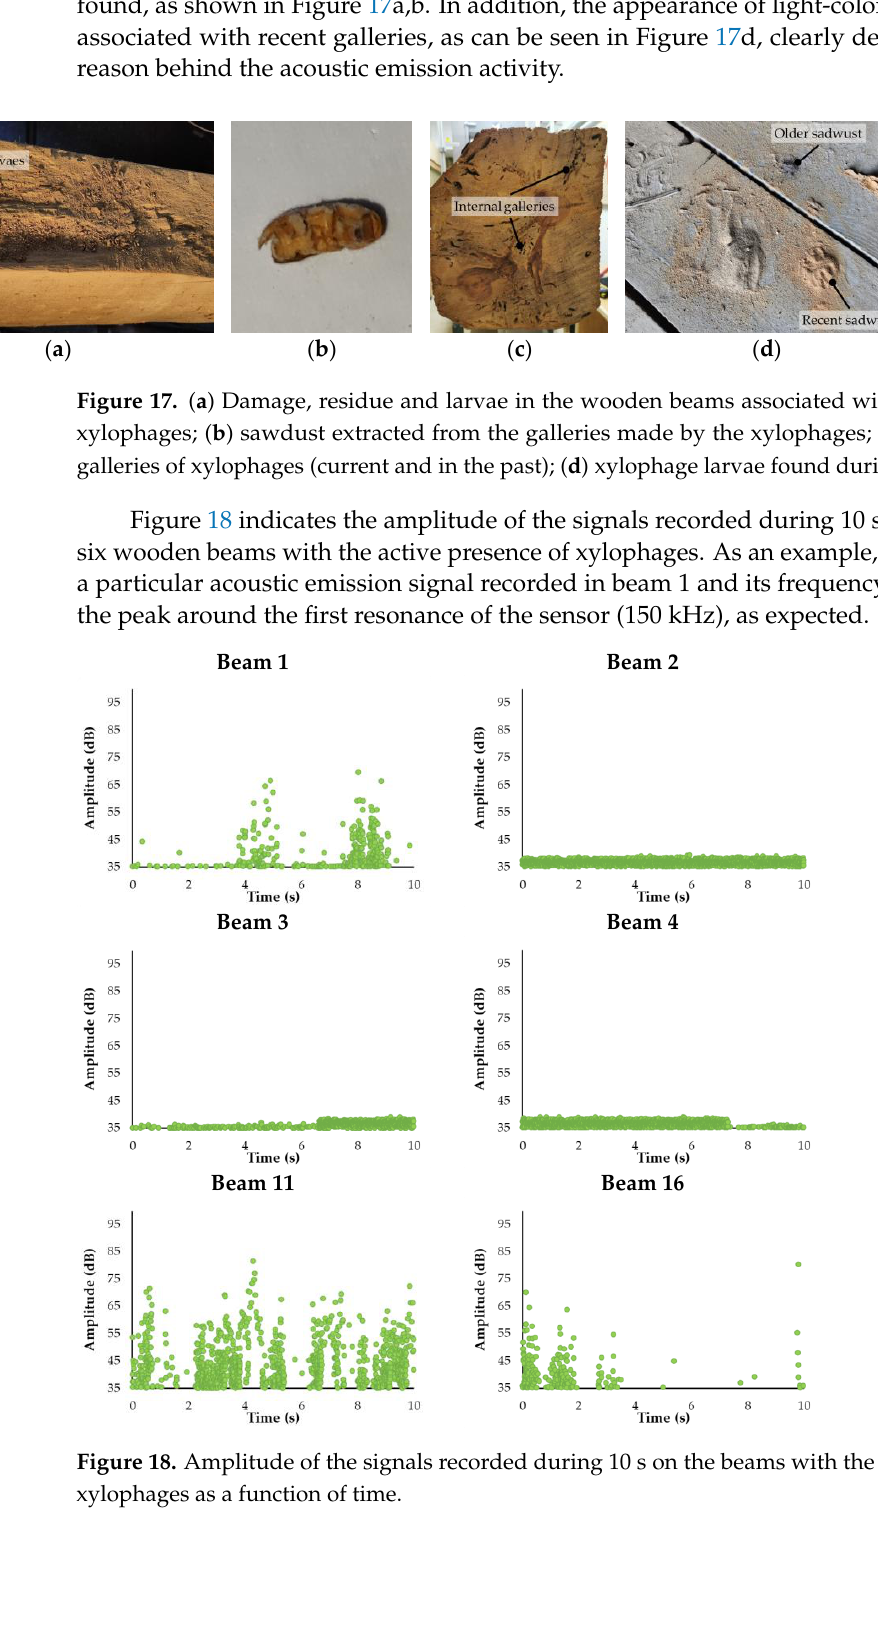
Figure 16. Acoustic emission signal recorded in the laboratory test. ( a ) transient signal; ( b ) frequency spectrum calculated in the time window indicated as a green box.